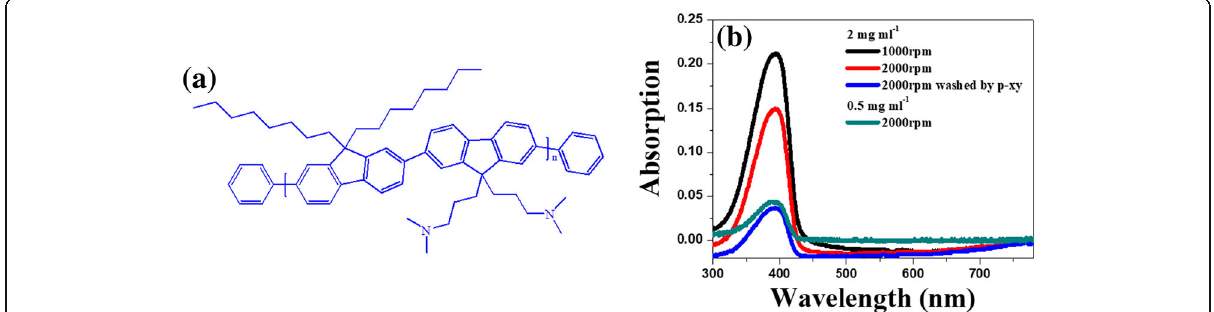
Fig. 2 a Molecular structure of PF-NR 2 . b Thickness variation of PF-NR 2 under different fabrication conditions measured by UV-Vis